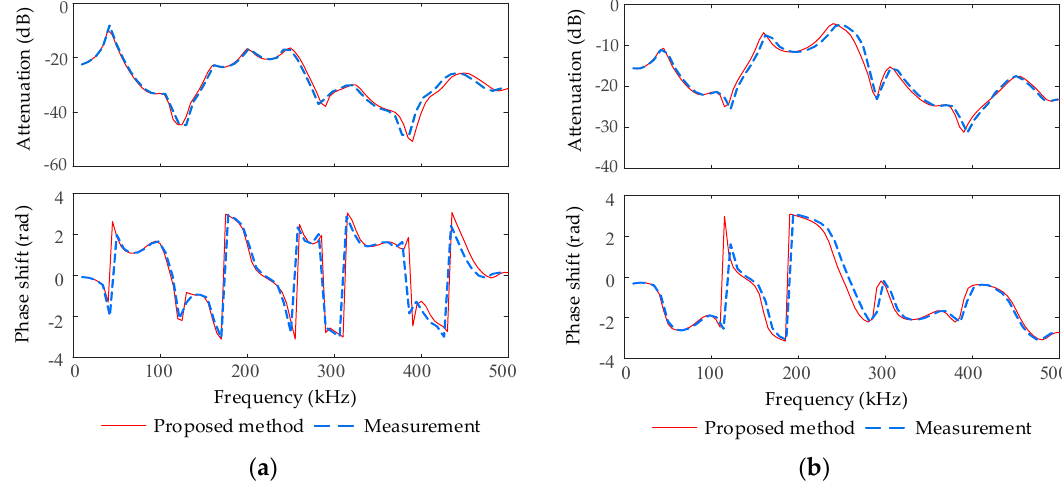
Figure 7. Frequency response characteristics of ( a ) the distribution network with three branch points and ( b ) the distribution network with two branch points.